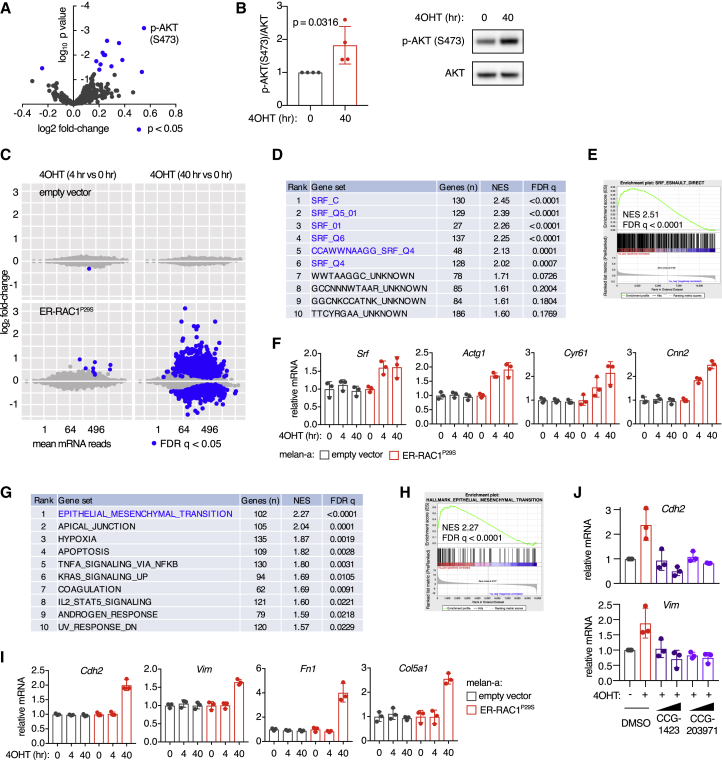
Effect of Acute Activation of RAC1P29S in Melanocytes on AKT and SRF/MRTF Effector Pathways(A) Reverse-phase protein array using ER-RAC1P29S melanocytes after RAC activation, expressed as a scatterplot with p values and log2 fold change compared with 0 h control (means from 3 independent experiments).(B) Densitometric quantification of phospho-AKT levels determined by immunoblotting, normalized to total AKT levels. Melan-a ER-RAC1P29S cells were treated with 4OHT at 500 nM (n = 4 independent experiments, one representative immunoblot shown); t test was used for statistical comparison.(C) RNA sequencing (RNA-seq) in ER-RAC1P29S melanocytes, expressed as scatterplots for empty vector cells and ER-RAC1P29S cells treated with 500 nM 4OHT. Blue dots represent values statistically different to 0 h values (false discovery rate [FDR] 5%).(D) Transcription factor target enrichment analysis of gene expression changes in melanocytes 4 h after activation of ER-RAC1P29S. Gene set enrichment analysis (GSEA) using the transcription factor target gene sets from the MSigDB database (Broad). NES, normalized enrichment score.(E) GSEA plot of the direct SRF target gene set from Esnault et al. (2014), using all genes expressed in the ER-RAC1P29S melanocytes at 4 versus 0 h 4OHT treatment.(F) Normalized RNA-seq read counts of canonical SRF/MRTF targets (n = 3 independent experiments).(G) Pathway enrichment analysis of gene expression changes in melanocytes 40 h after activation of ER-RAC1P29S. GSEA using the curated hallmark gene set collection from MSigDB.(H) GSEA plot of the epithelial-to-mesenchymal transition (EMT) hallmark gene set from MSigDB using gene expression differences in ER-RAC1P29S melanocytes treated for 40 h with 4OHT compared with 0 h control.(I) Relative mRNA of mesenchymal markers in melanocytes with activated ER-RAC1P29S, quantified using RNA-seq (n = 3 independent experiments).(J) Effect of treatment with SRF/MRTF inhibitors on mesenchymal marker induction by ER-RAC1P29S. Cells were pre-treated with 5–10 μM CCG-1423 or CCG-203971 1 h before 4OHT treatment (1 μM) for 48 h (n = 3 independent experiments); mRNA levels were determined using qPCR and normalized to Gapdh expression.For all graphs: bars represent means ± SD. See also Figure S2.